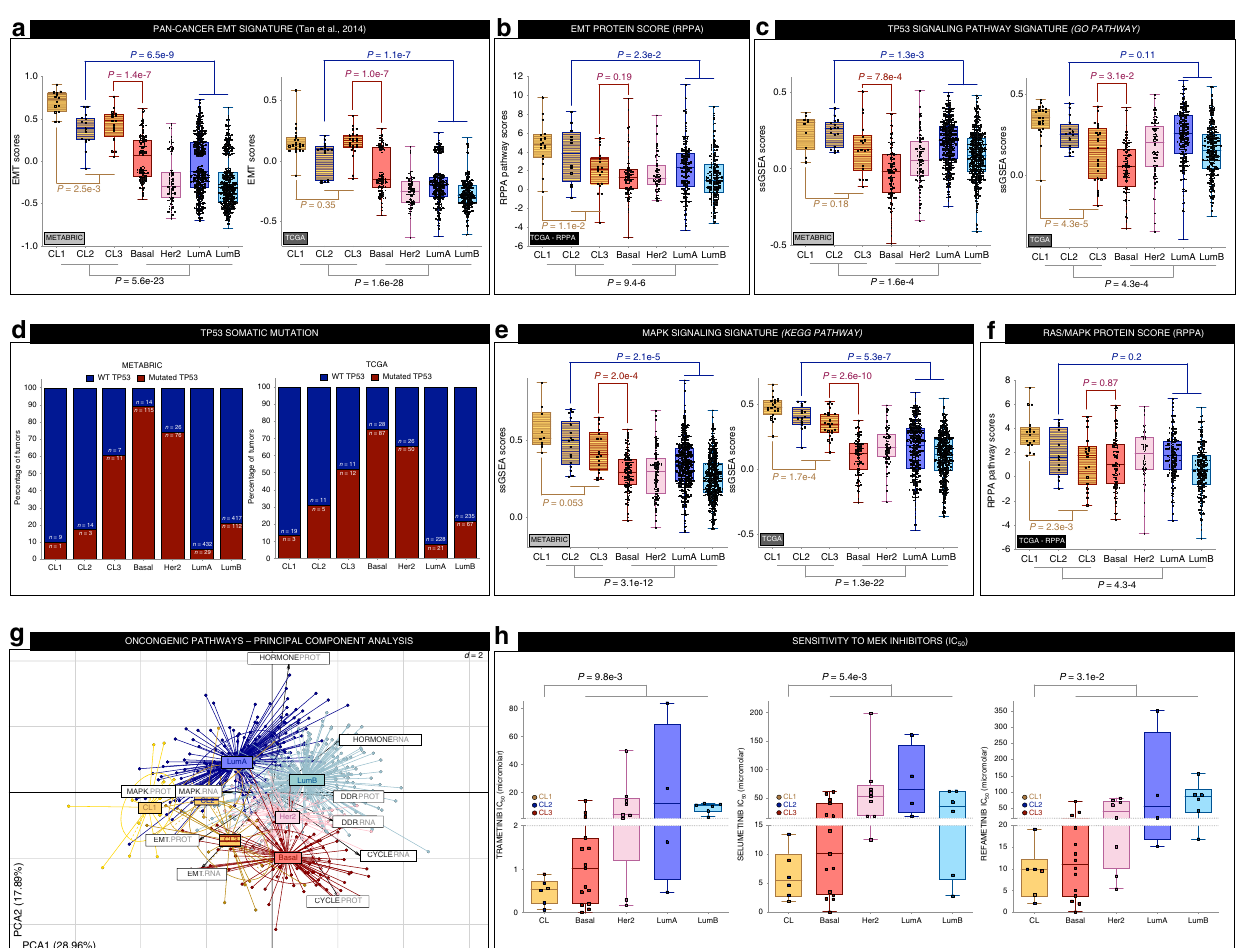
Fig. 6 Claudin-low subgroups jointly display high EMT features and MAPK pathway activation. a , c , e ssGSEA score distribution for each molecular subtype, from METABRIC and TCGA cohorts, related to a EMT, c TP53, and e RAS/MAPK pathways. d TP53 somatic mutation distribution across breast molecular subtypes of METABRIC and TCGA cohorts. b , f Protein-based pathway scores (RPPA data) for each molecular subtype from TCGA breast tumors related to b EMT and f RAS/MAPK. g Principal component analysis (PCA) of TCGA breast tumors according to EMT, RAS/MAPK, cell cycle/ proliferation, hormone-related and DDR pathways at RNA (ssGSEA scores), and protein (RPPA scores) levels. For each sample, molecular subtype is indicated in color and variables (pathways) are highlighted in black squares. h IC50 distribution according to molecular subtype for three different MEK inhibitors available in the GDSC database. Claudin-low cell lines commonly exhibit higher sensitivity to MAPK inhibitors than other breast molecular subgroups. Wilcoxon tests. Boxplot: center line, median; box limits, upper and lower quartiles; whiskers, minimum to maximum; all data points are